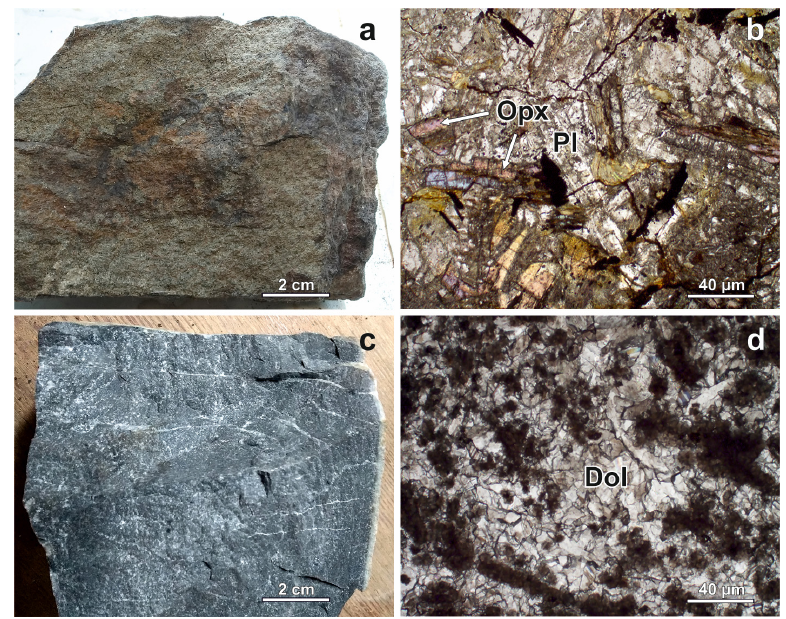
Figure 3. Basaltic ( a , b ) and carbonatite-like rocks ( c , d ) from the Poperechnoye deposit. ( a , c )—hand specimens; ( b , d )—thin section microphotographs.